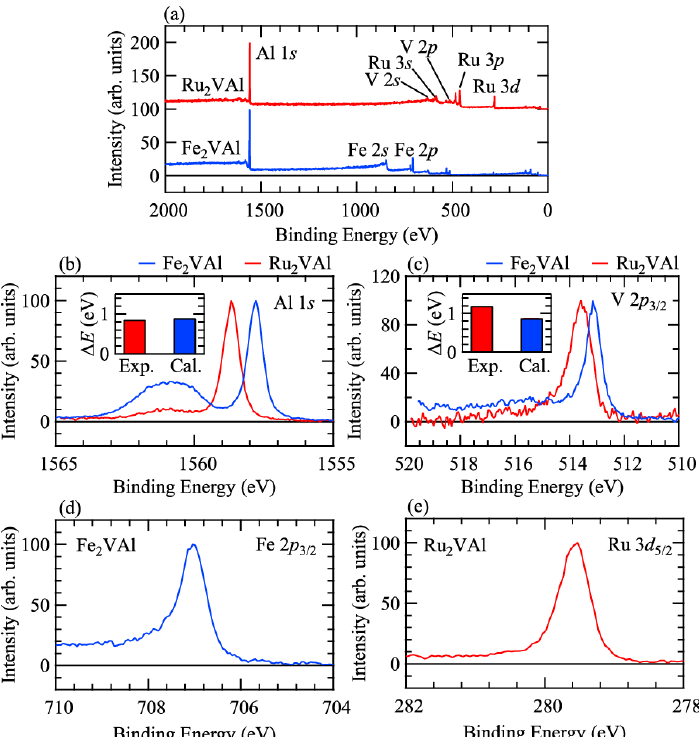
Figure 4. Wide photoemission spectra ( a ) and core level photoemission spectra of Al 1 s ( b ), V 2 p 3/2 ( c ), Fe 2 p 3/2 ( d ) and Ru 3 d 3/2 ( e ) states Fe 2 VAl and Ru 2 VAl. ( c ), Fe 2 p 3/2 ( d ) and Ru 3 d 3/2 ( e ) states Fe 2 VAl and Ru 2